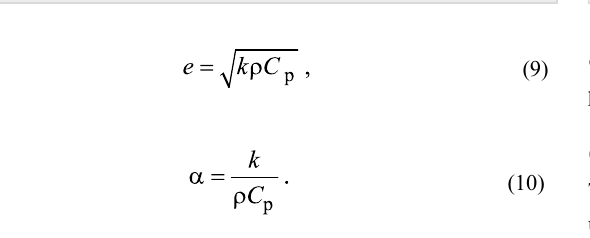
Figure 7: Trend of (a) thermal conductivity and (b) thermal effusivity of the PVA solution (0 kGy) and ZnS nanofluids as a function of the radia- tion dose.